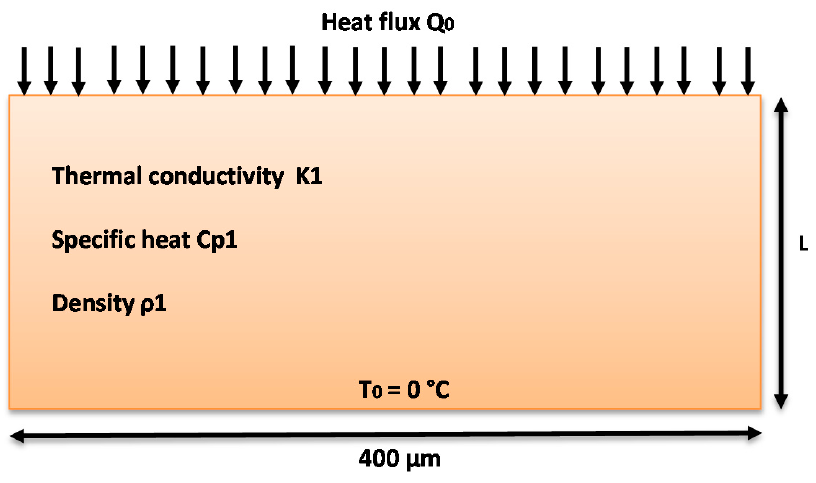
Figure 2. 1-D single-layer structure.